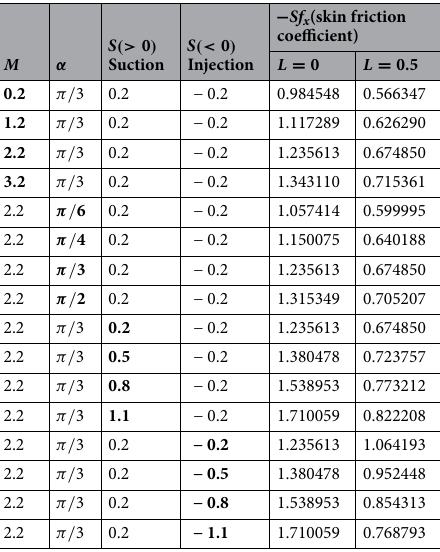
Table 4. Numerical findings of Sf x with velocity slip ( L values of influencing parameters are highlighted with bold